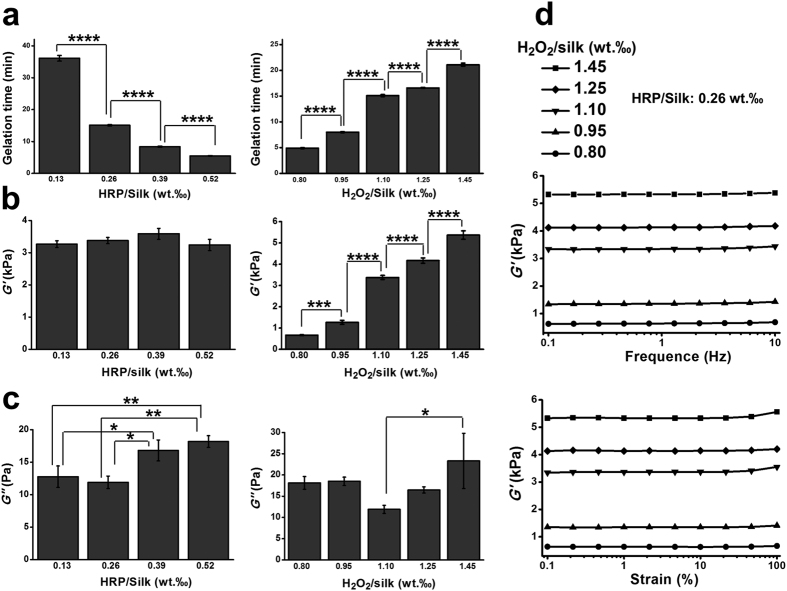
Gelling time and SF hydrogel mechanical properties.(a) The HRP and H2O2 influence on the hydrogel gelling time. (b,c) the HRP and H2O2 effects on the storage contents and the hydrogel’s loss modulus, respectively. In (a–c), Left: H2O2/Silk was fixed at 1.10‰ (wt/wt); Right: HRP/Silk was fixed at 0.26‰ (wt/wt). (d) hydrogel representative frequency and strain sweeping. (a–c: n = 5). *P < 0.05, **P < 0.01, ****P < 0.0001.